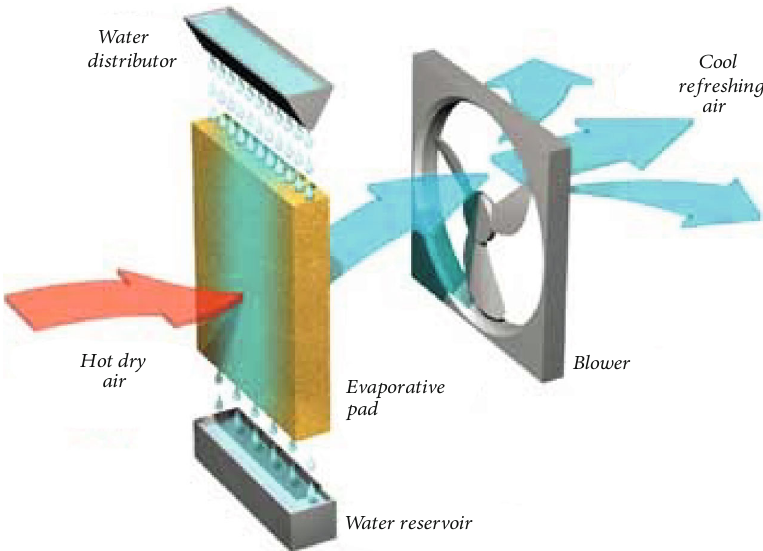
Figure 1: Conventional pad pump system [1]. Table 1: Research work carried out for di ff erent